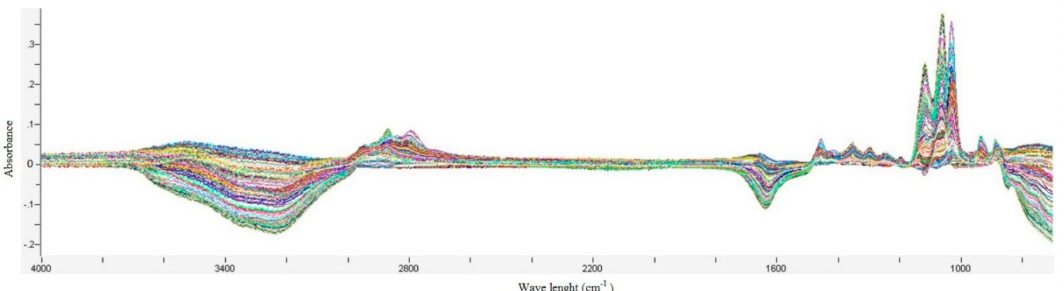
Figure 1. All spectra from the calibration solutions for the MDEA-H 2 O, MEG-H 2 O, MDEA-MEG-H 2 O, and MDEA-MEG-H 2 O-CO 2 systems.